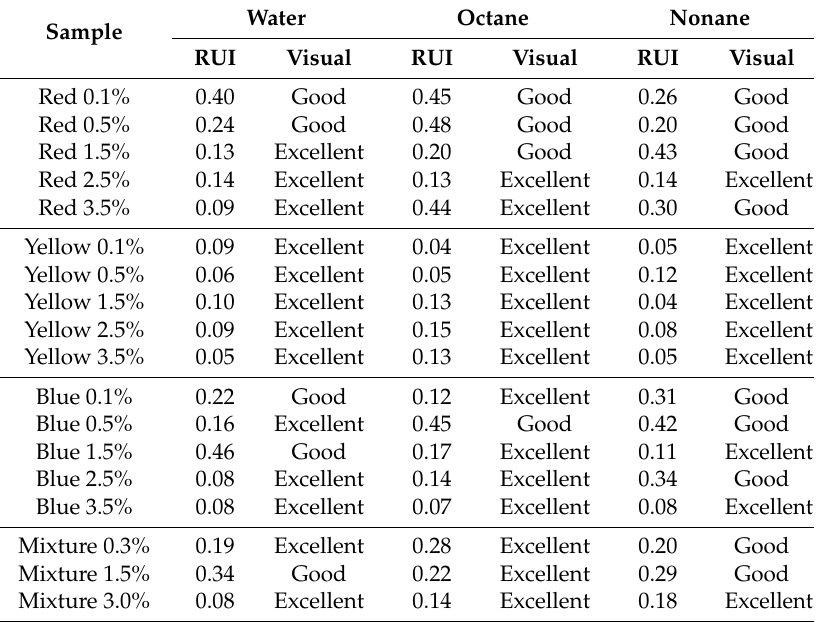
Table 11. RUI and visual levelness evaluation of dyed wool